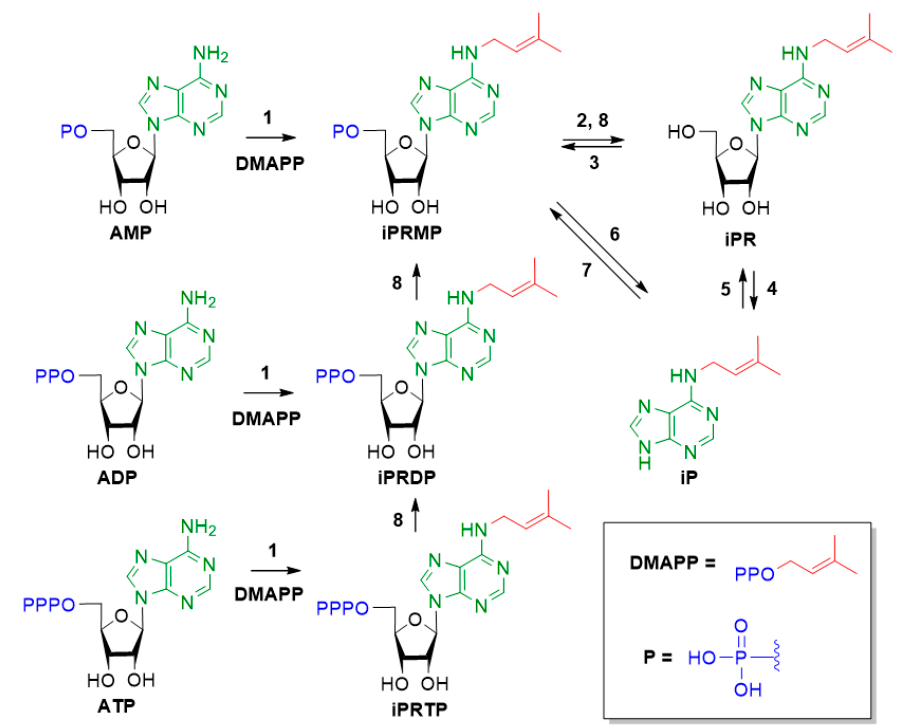
Figure 2. Scheme of the iP biosynthesis. ( 1 )—isopentenyltransferase; ( 2 )—5 ′ -ribonucleotide phosphohydrolase (5 ′ -nucleotidase); ( 3 )—adenosine kinase; ( 4 )—adenosine nucleosidase; ( 5 )—purine nucleoside phosphorylase; ( 6 )—phosphorybohydrolase phosphoribosyltransferase; ( 8 )—phosphatase.